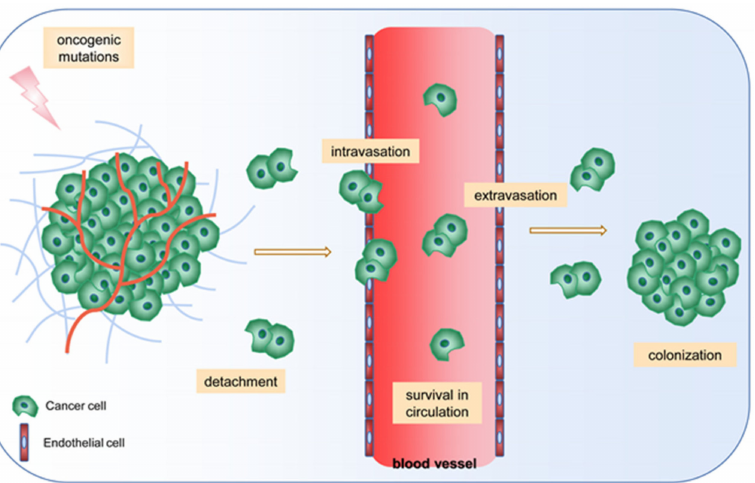
Figure 2. Steps of tumor metastasis. The process of tumor metastasis mainly goes through five stages: (1) local detachment of tumor cells and invasion of surrounding tissues (resistance to anoikis); (2) intravasation, where tumor cells enter the blood or lymphatic system; (3) tumor cell transport and survival in the circulatory system; (4) exudate leakage from circulation into distal tissues; (5) colonization, to form metastatic foci. Obstruction of any of these steps would prevent the formation of the metastasis. As early as 1889, Stephen Paget first proposed the seed and soil hypothesis, which has been widely recognized as the critical theory for tumor